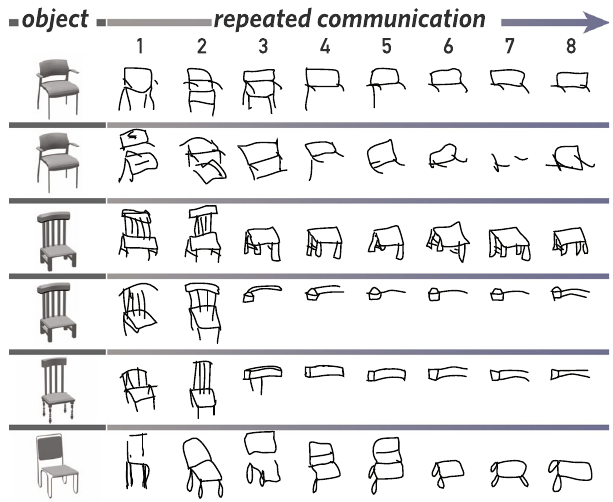
Fig. 1 | Examples of sketches produced in a repeated visual communication task. Participants in our study produced sketches depicting the same object (left) overaseriesofeightblocks(right).Imagesofobjectswererenderedfrom3Dmesh models in the ShapeNet database and appear in this fi gure with